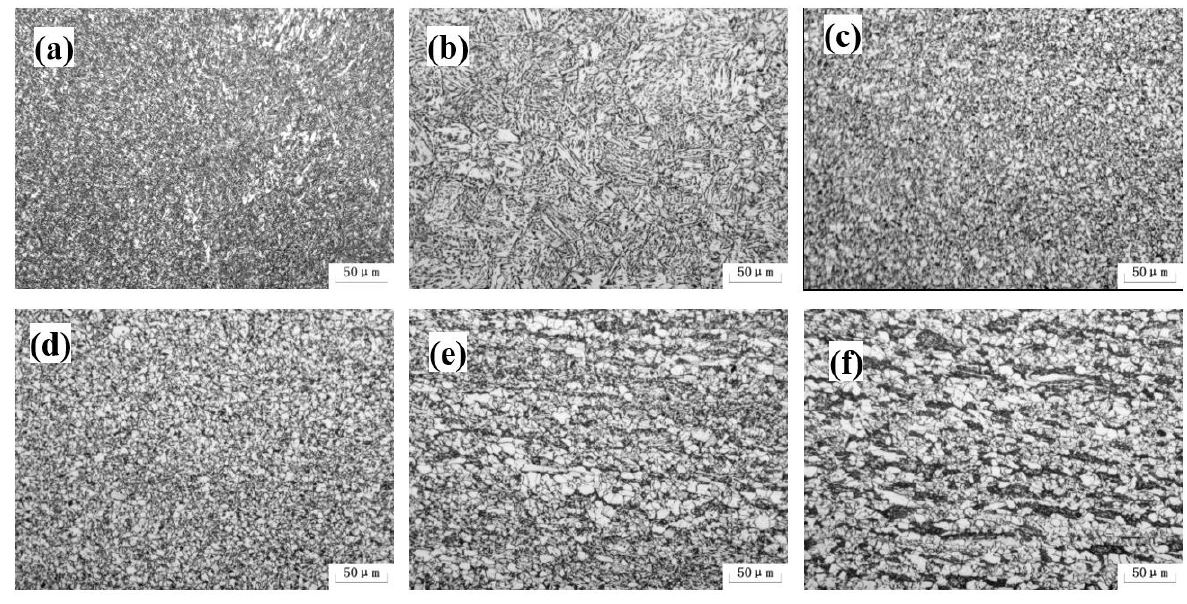
Figure 2. Microstructure of actual welded joints of 0 Nb steel: ( a ) weld seaming; ( b ) CGHAZ; ( c ) FGHAZ; ( d ) ICHAZ; ( e ) SCHAZ; ( f ) base metal.